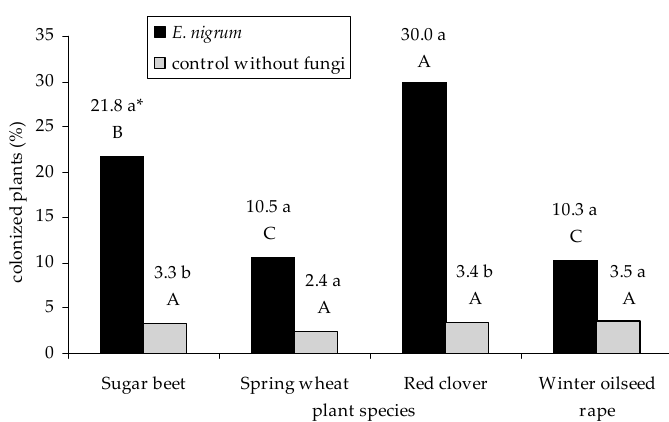
Table A4. Sugar beet seedlings were the most colonized by UP_EPC_69, while the seedlings of